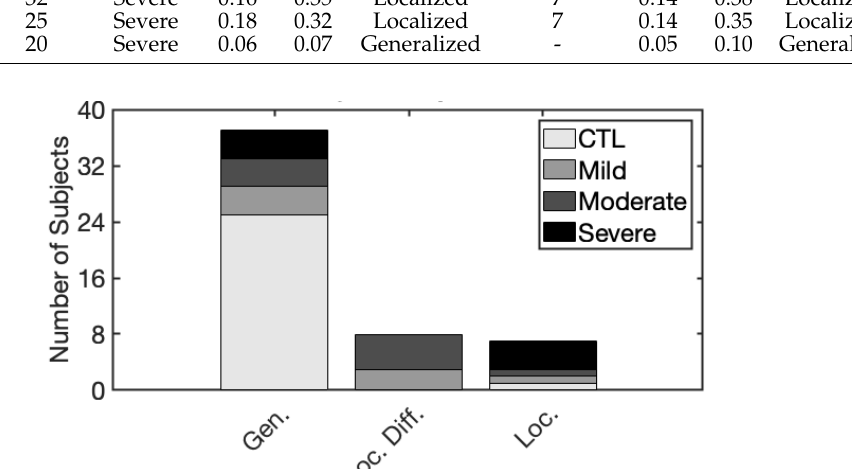
Figure 11. Excess fluid spatial presentations obtained from the analysis of CF and control subjects. The distribution of spatial presentations among CF subjects differs from the control group ( p < 0.01, Fisher’s exact test).